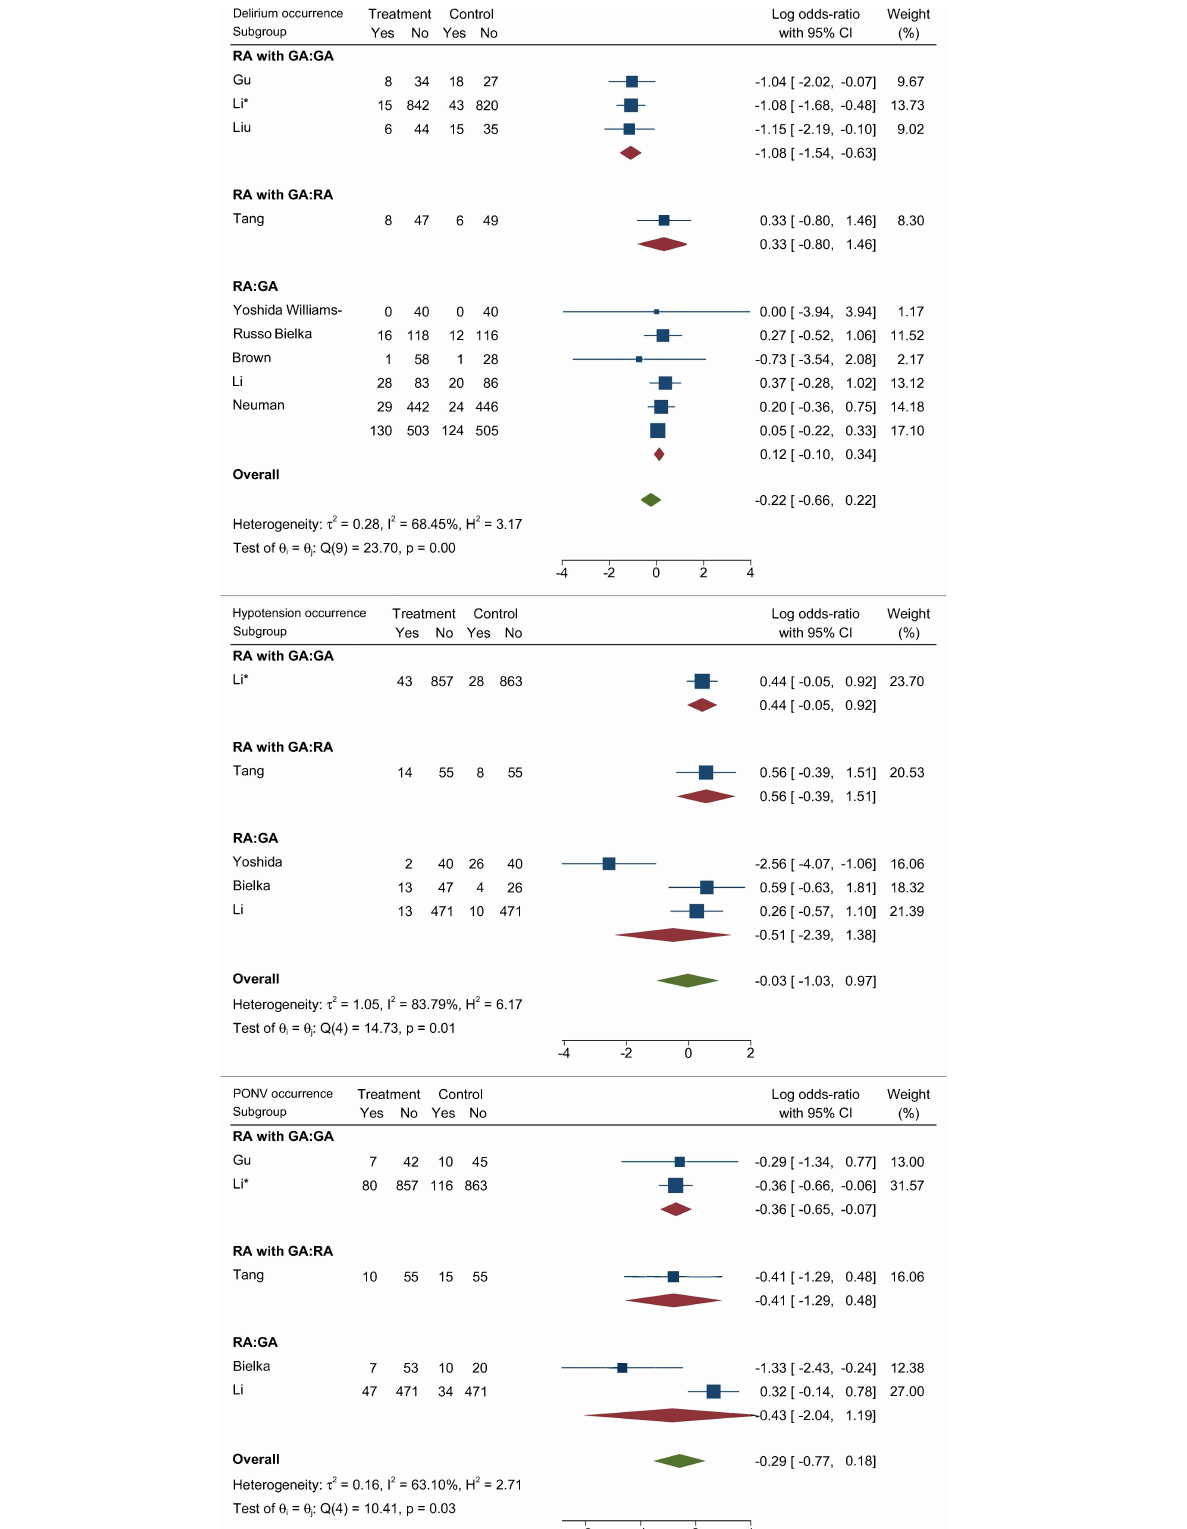
Frontiers in Aging